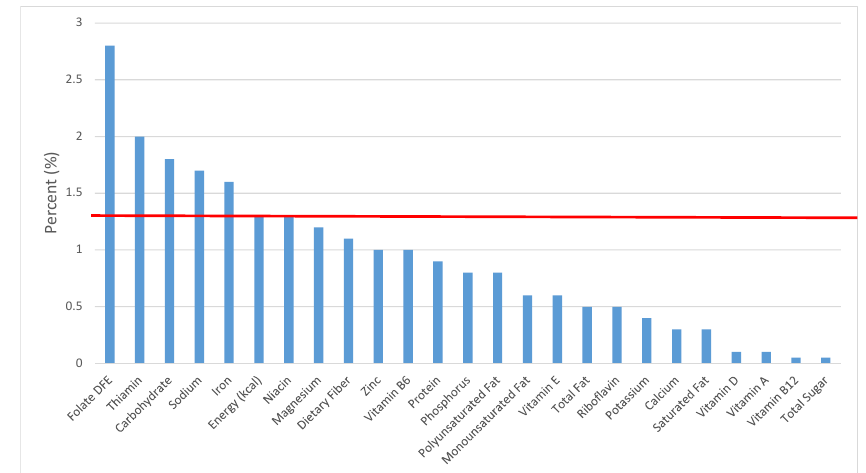
Figure 19. Cooked grains as sources of energy and nutrients for children and adolescents 9–13 years old ( N = 1730, daily intake data): DFE = Dietary Folate Equivalents; solid red line represents percentage of energy (kcal) provided in the diet relative to nutrients—nutrients above the red line show the grain food’s contribution to nutrient density.